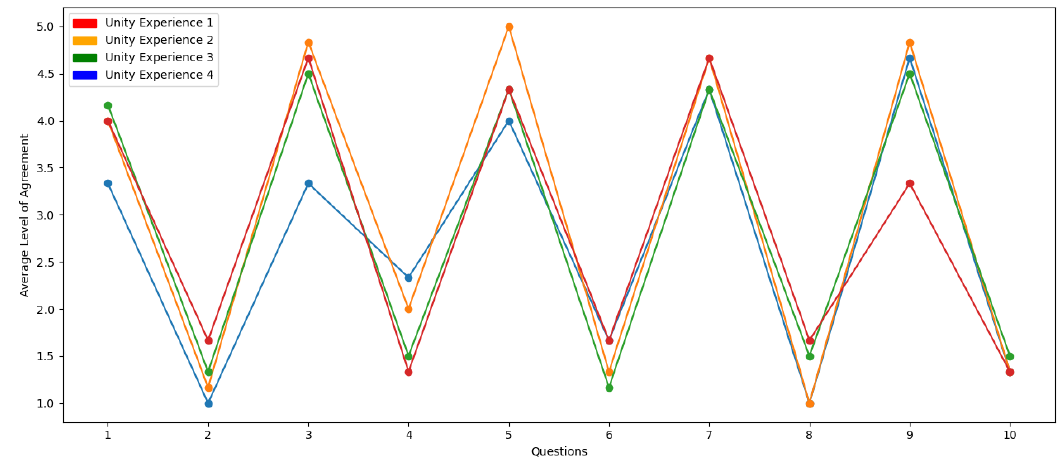
Figure 9. Average scores on questions per Unity experience level.